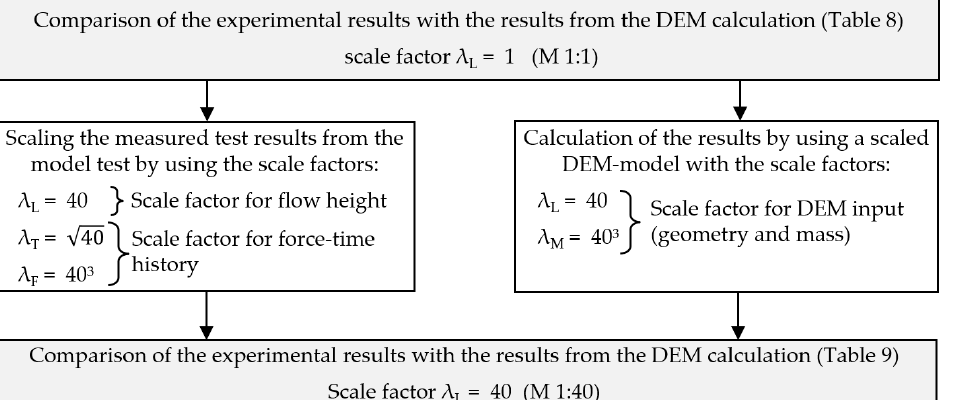
Figure 11. Concept of the procedure for comparing the scaled results from the model test and the DEM model.